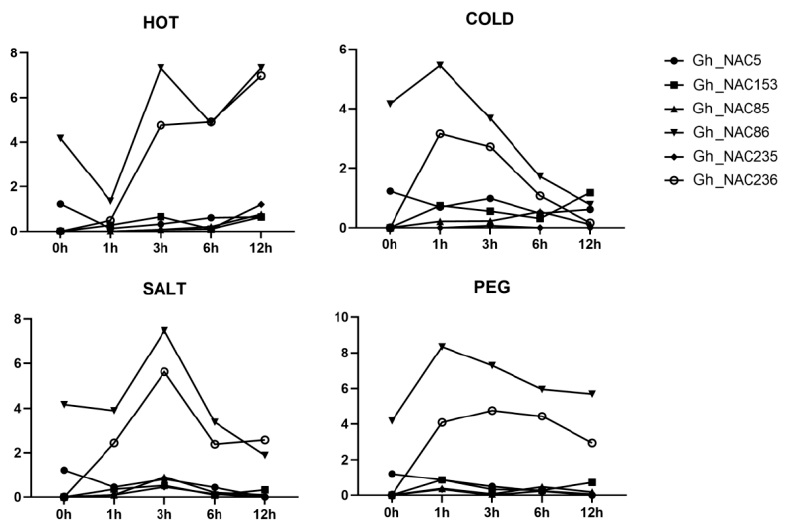
Figure 10. Expression changes of 6 NAC genes after different stress treatments .